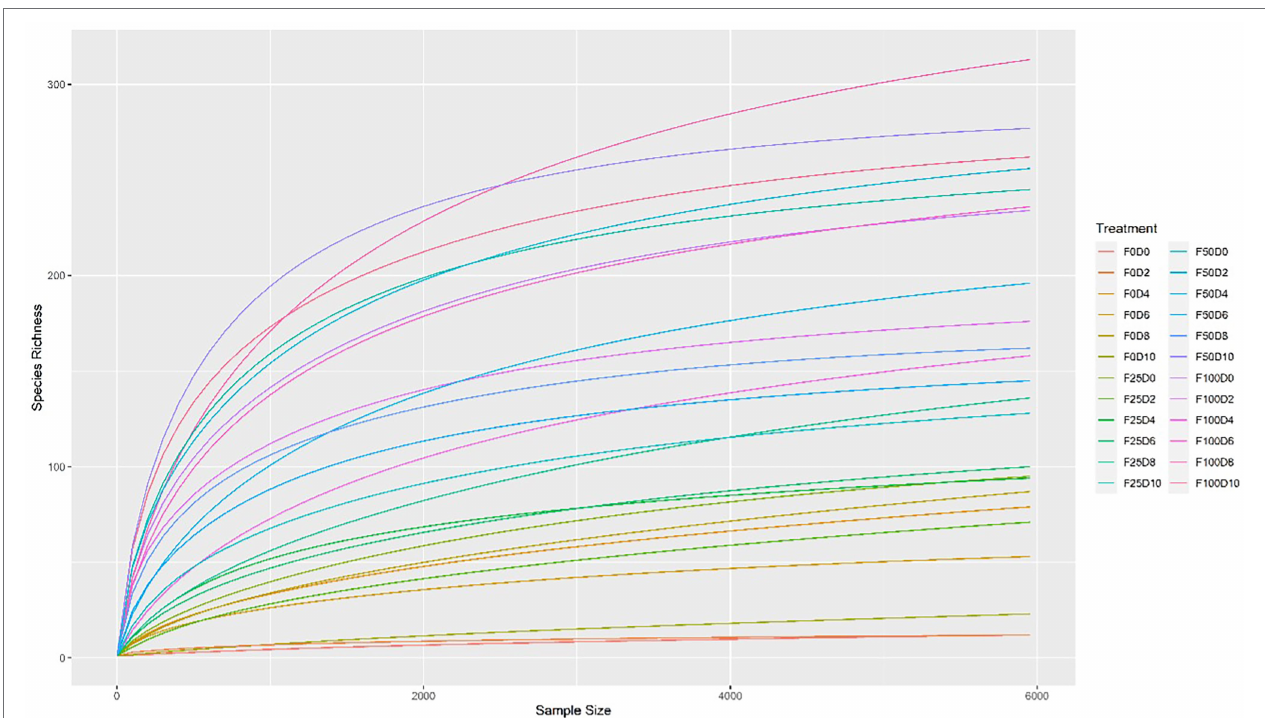
FIGURE 1 | Rarefaction curves of partial sequences of the 16S rRNA gene. Rarefaction analysis of 16S rRNA gene sequence data to estimate the microbial diversity of the 24 treatments.